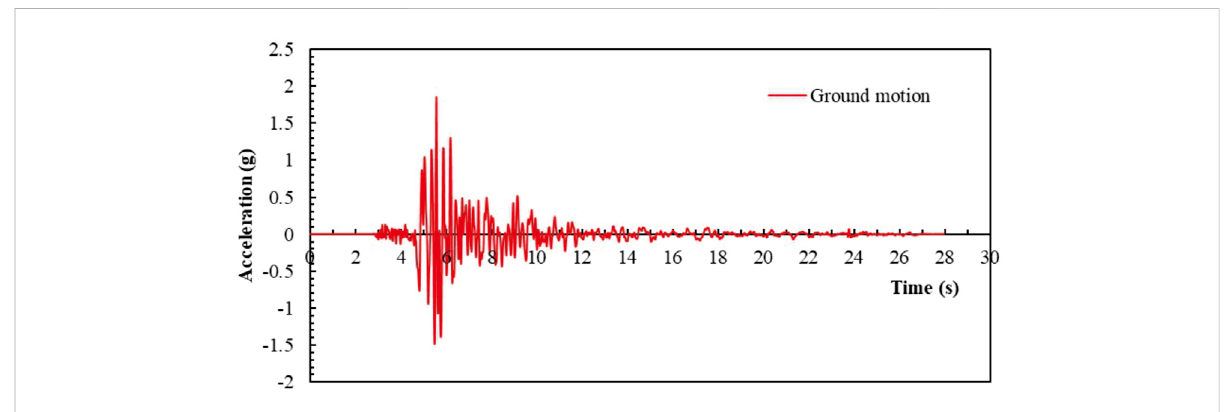
FIGURE 7 Seismic acceleration used in the case